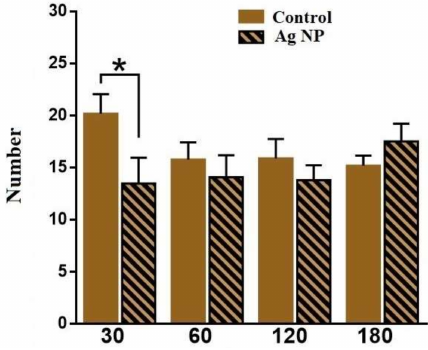
Figure 11. Number of transitions between the dark and the light chambers for the different periods of the